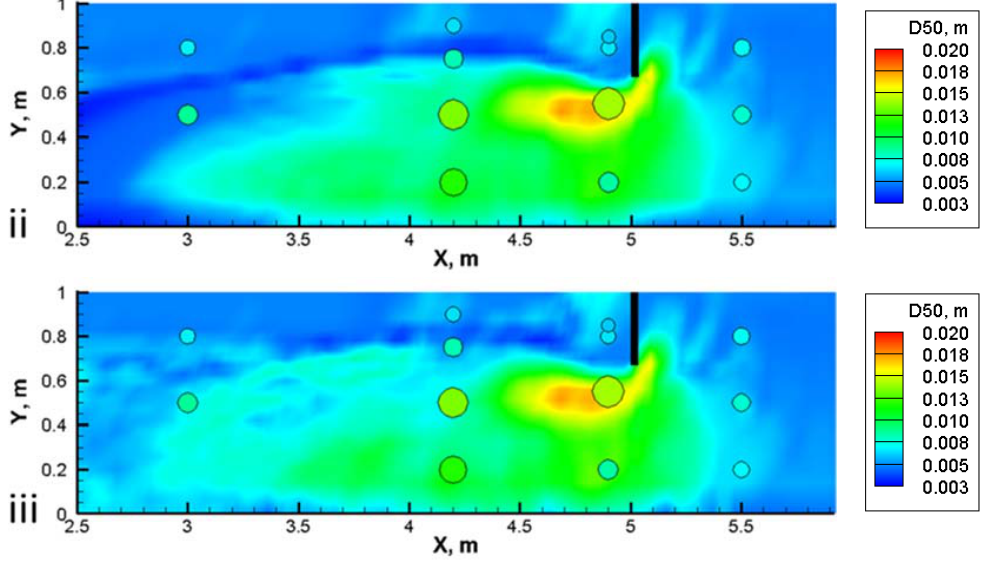
Figure 12. Measured (circles) and calculated (ii: Wilcock and Crowe formula; iii: combined approach) d 50 distribution at Q = 72 L/s.